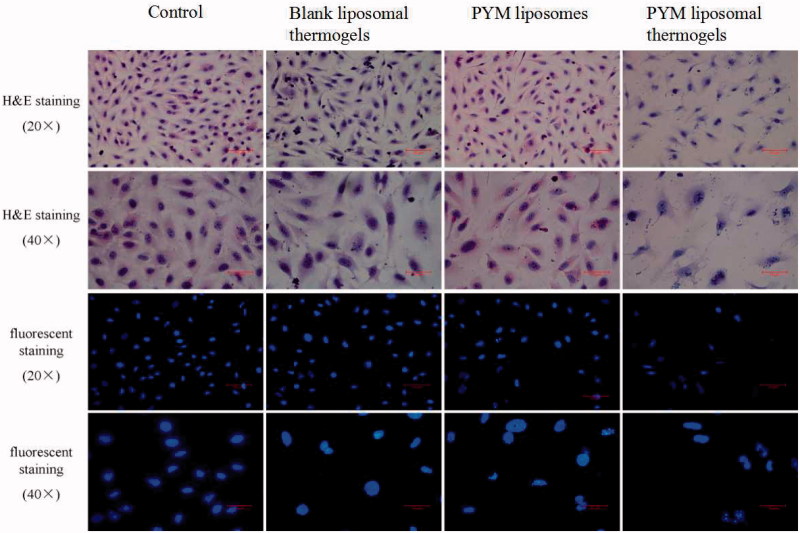
Morphological changes of EA.hy926 cells exposed to blank liposomal thermogels, PYM liposomes and PYM liposomal thermogels for 24 h. Cells were stained by H&E and fluorescent dye, respectively.